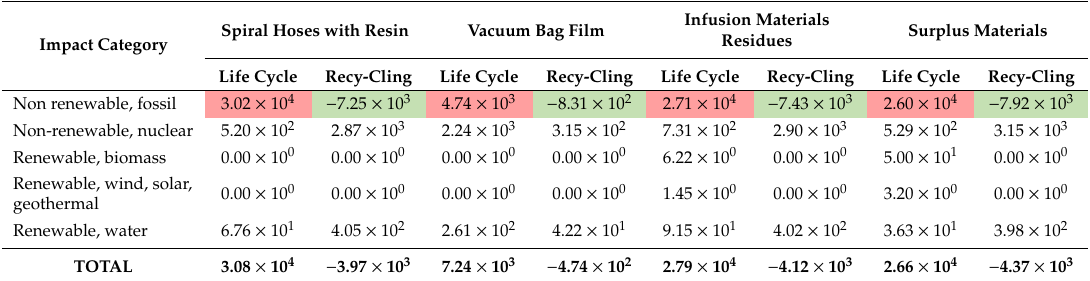
Red highlight—the highest level of negative environmental consequences for the analyzed impact categories. Green highlight—the highest level of positive environmental consequences for the analyzed impact